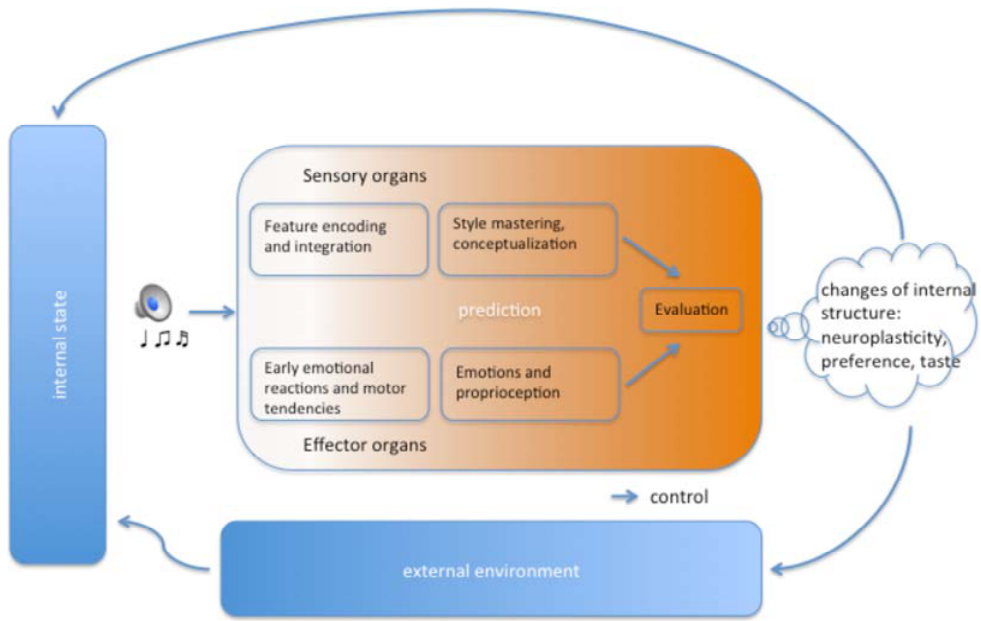
Figure 2. Schematic illustration of the subprocesses of a musical aesthetic experience (simplified and adapted from Brattico et al. [9]) and how repeated exposure modifies the internal structure of the music agent, consequently changing his or her external environment and internal state in a continuous